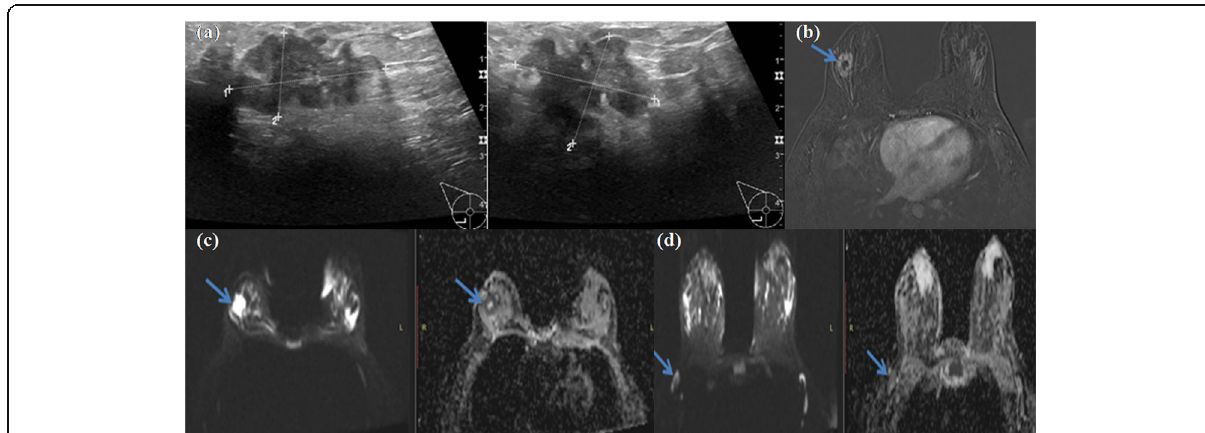
Fig. 6 A case of pathologically proven IDC grade II (T2). a Breast U/S revealed a partially defined irregular shaped hypoechoic mass lesion at right 7 – 8 o ’ clock. b DCE-MRI revealed right partially circumscribed ring enhancing breast mass with central breakdown at the lower outer quadrant with restricted diffusion (bright on DWI and dark on ADC with central bright signal (breakdown)). c Right axillary pathologically enlarged LN showing restricted diffusion in the DWI-MRI. d In this case, the tumor size (T) detected by DCE-MRI and ultrasound were correlating with pathological specimen results, while DWI-MRI was able to detect the pathological axillary LN that was missed by DCE-MRI and SM